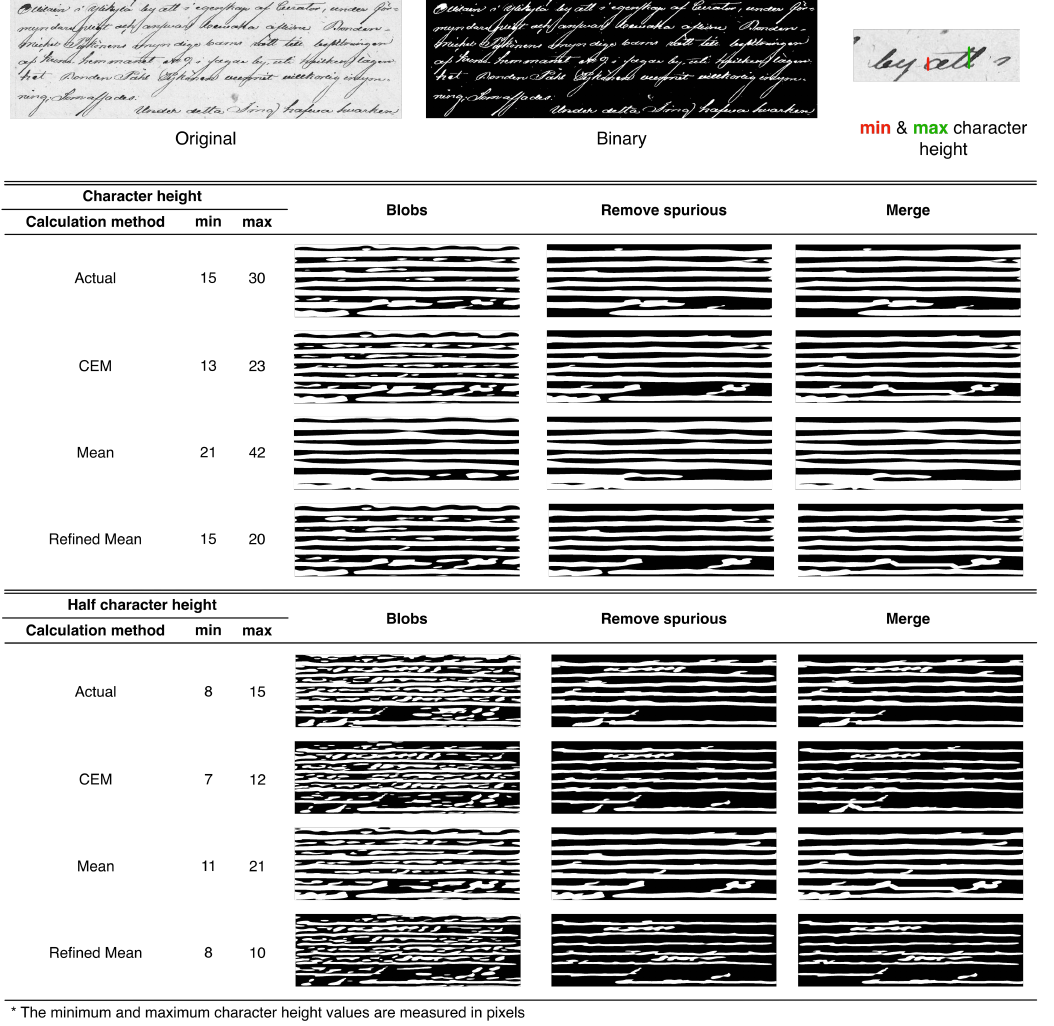
Figure 7. Visualization of the effect of character height estimation method. Apparently the half values of range values provide thinner blob lines that are more apart while provoking spurious blob